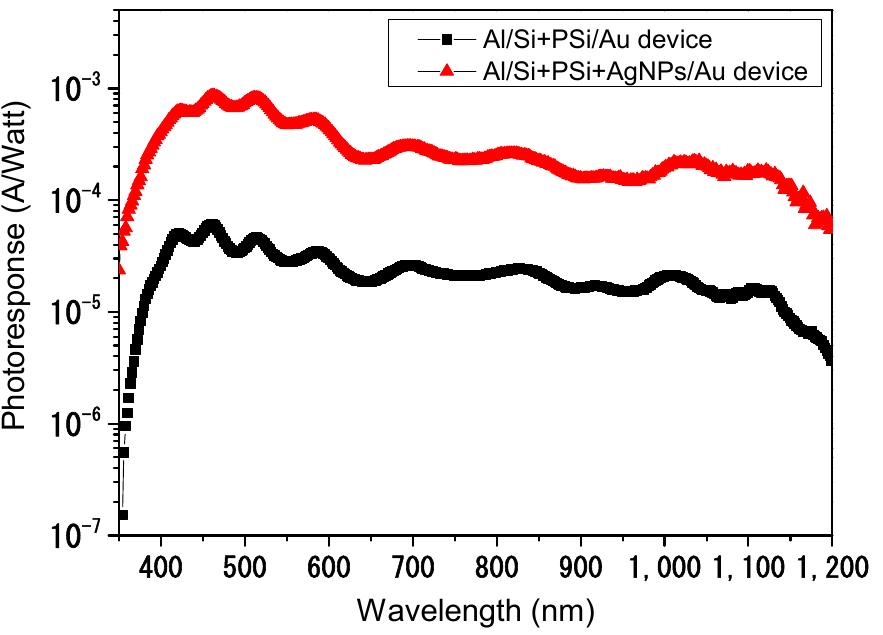
Figure 8. Comparison between the spectral photoresponse of Al/Si+PSi/Au and Al/Si + PSi + AgNPs/Au Schottky photodiodes at zero biasing.